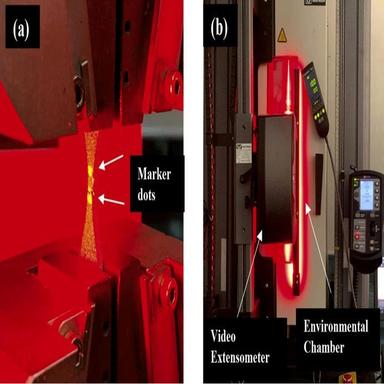
a) Sample at room temperature showing two marker dots, b) Instron environmental chamber used for high-temperature tensile testing.